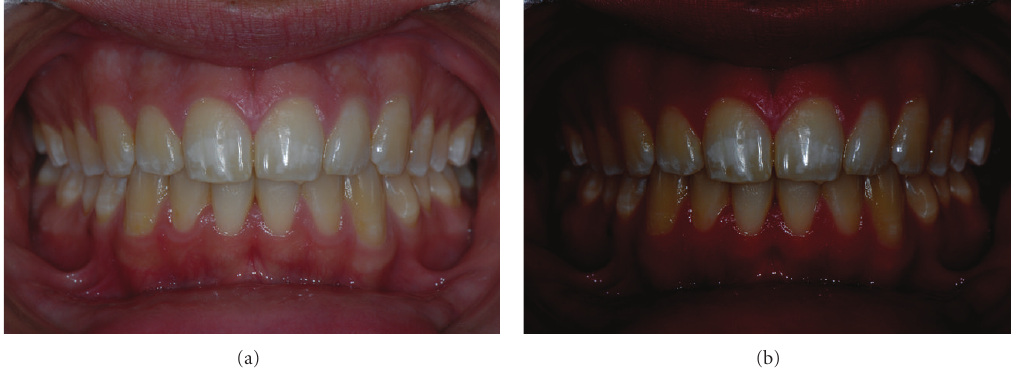
Figure 1: (a) Initial frontal picture. (b) Software-modified initial frontal picture.